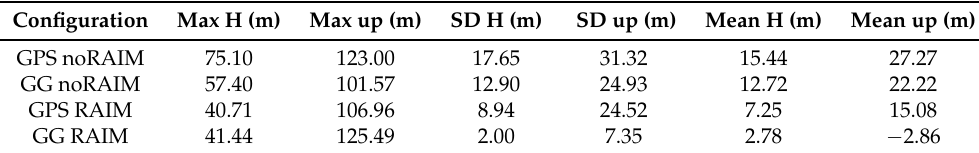
Table 4. Position error statistics considering only reliable epochs.